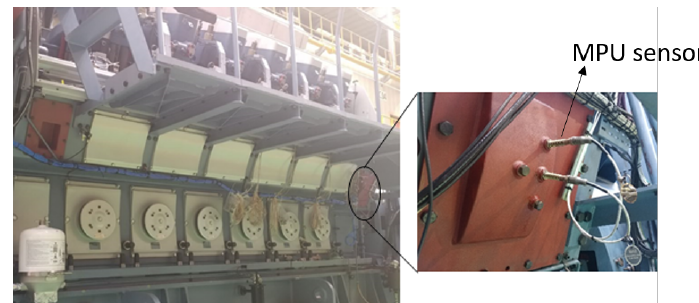
Figure 4. Four-stroke marine diesel engine with the location of the pickup sensor.